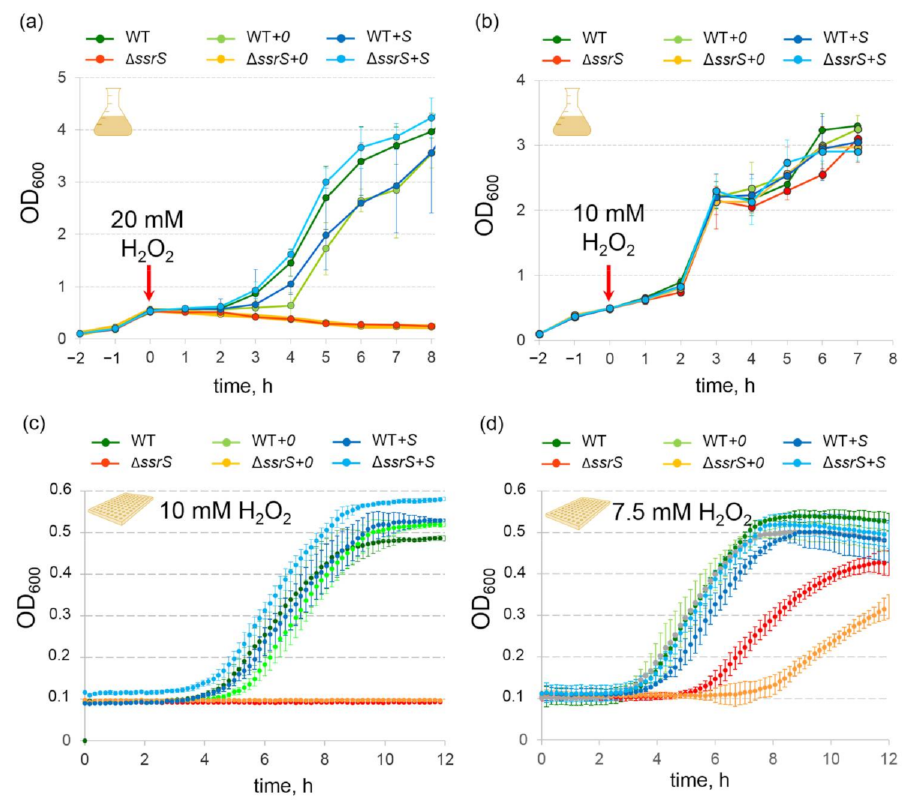
Figure 4. Lack of 6S RNA leads to lethality of E. coli in the presence of high concentrations of H 2 O 2 . ( a , b ) Growth curves of E. coli strains (three biological replicates) in the presence of 20 or 10 mM H 2 O 2 (f.c.) that were directly added to exponentially growing (OD 600 ~ 0.5) E. coli flask cultures. Optical density was monitored manually. ( c , d ) Growth of E. coli strains (3 biological replicates) in 96-well plates monitored by an automated scanning reader. Here, E. coli strains were grown in LB medium up to an OD 600 ~ 0.5 in the absence of H 2 O 2 , followed by 1:5 dilution of culture medium containing different amounts of H 2 O 2 (f.c. 10 or 7.5 mM) before resuming growth and monitoring of optical